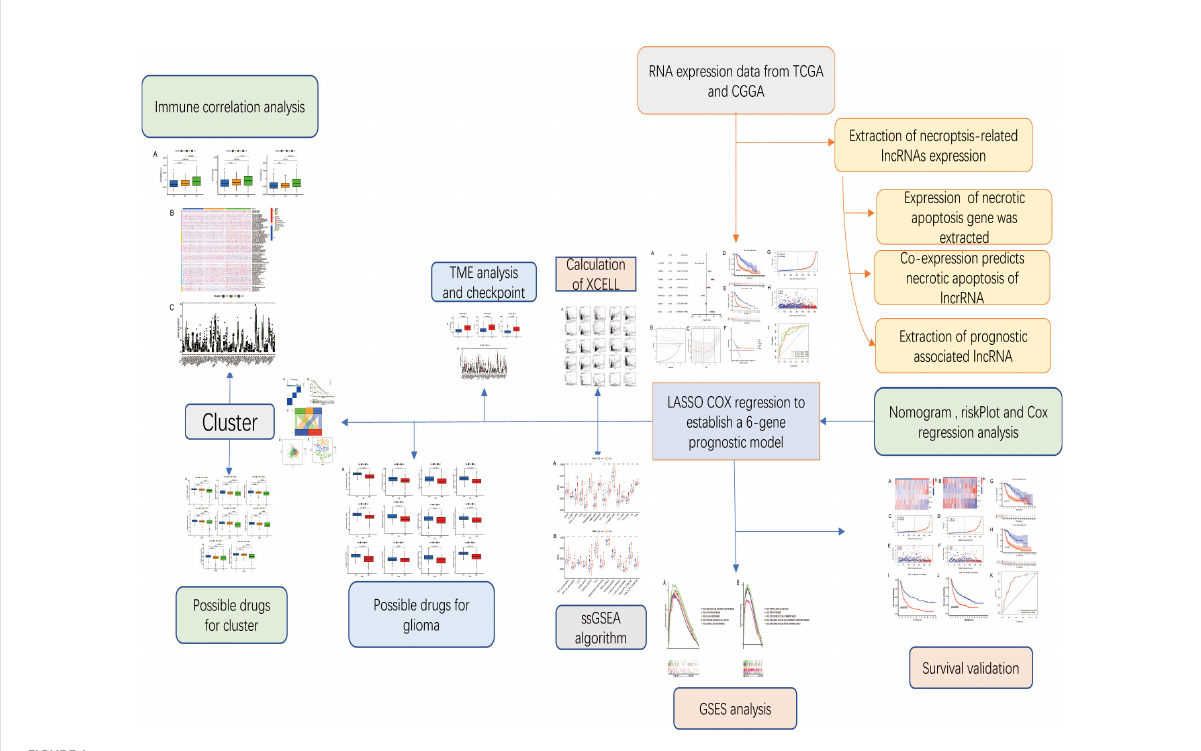
FIGURE 1 Work fl ow diagram. The speci fi c work fl ow graph of this